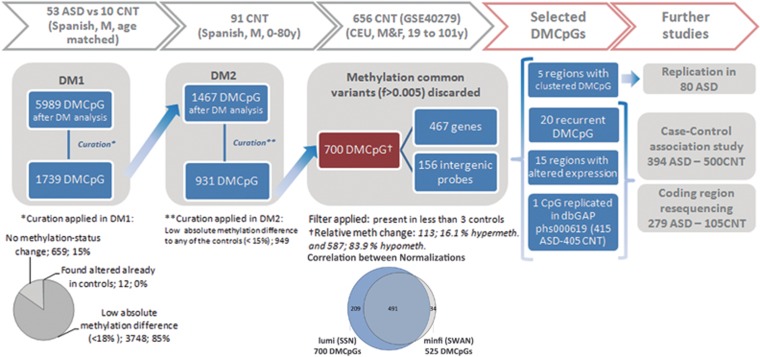
Pipeline followed for the differential methylation analyses with detailed filtering criteria. For the first two comparisons (DM1 and DM2), we established a P-value threshold <0.01, whereas in the third comparison (DM3) we searched for rare methylation alterations in a large control cohort (frequency <0.005). We obtained 700 DMCpGs, 156 intergenic probes and 544 of them encompassing 467 genes and 10 miRNA. We selected for further analyses the DMCpGs found in more than one case, including the dbGAP study (accession=phs000619), the differentially methylated regions, and the DMCpGs associated with significant cis-acting expression changes. Further studies with patients and controls were performed, for which some public accession data were added to the cohorts (data not added). Venn-diagram: correlation data between two normalization methods showing high concordance. ASD, autism spectrum disorder; C, controls; DM, differential methylation analysis; DMCpGs, differentially methylated CpGs; F, females; M, males.